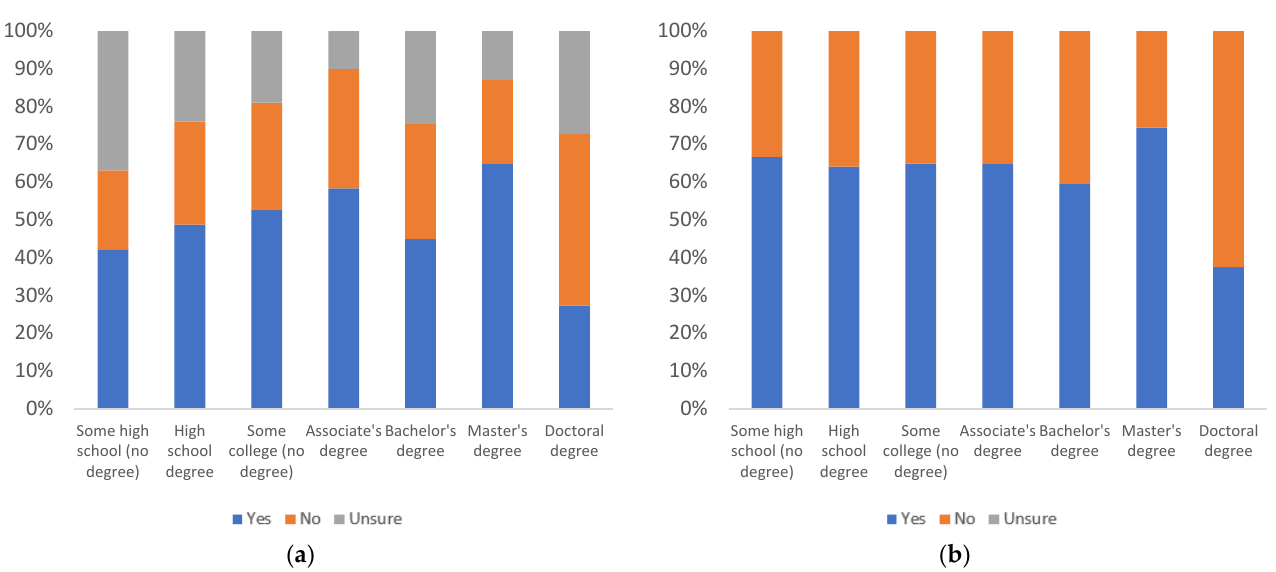
Figure 34. Label trustworthiness judging use, by education level: ( a ) with uncertain respondents (left) and ( b ) without uncertain respondents (right).